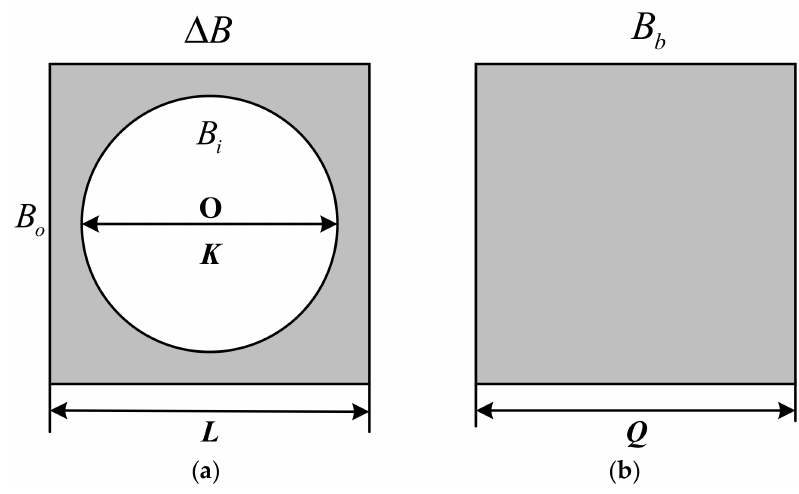
Figure 4. Defined structural operators used in the IBGSM method. ( a ) structural operator ∆ B ; ( b ) structural operator B b